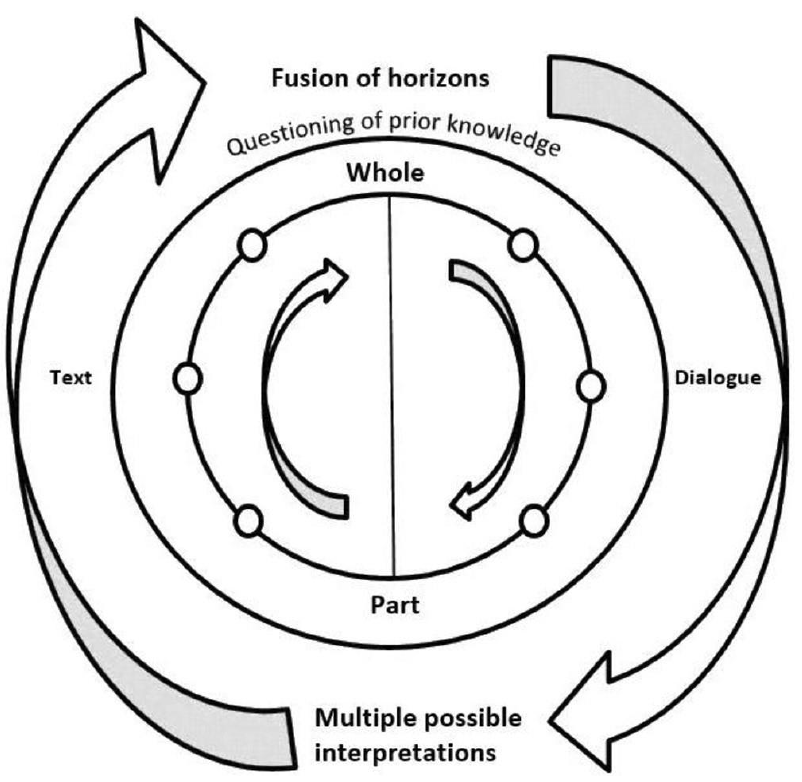
Figure 1. The Hermeneutic Circle, Peat et al 2019 [16] (p.9).